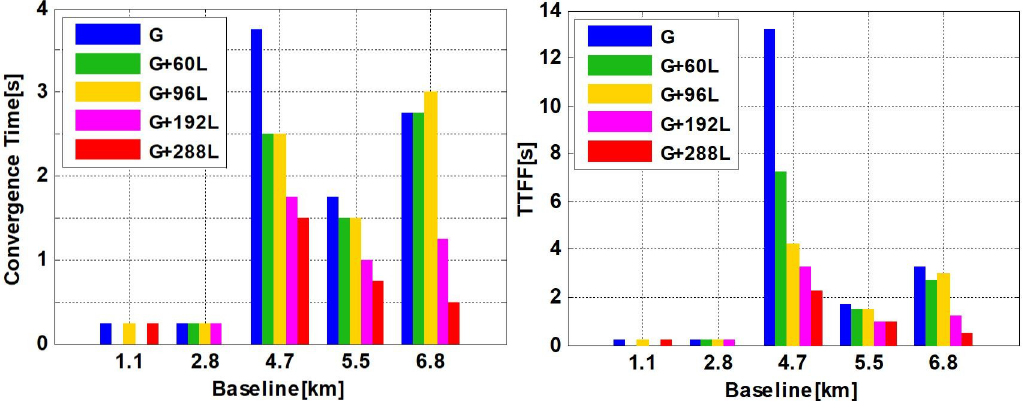
Figure 7. Average convergence time ( left panel ) and TTFF ( right panel ) of different LEO constellations augmented GPS RTK positioning for five short baselines.